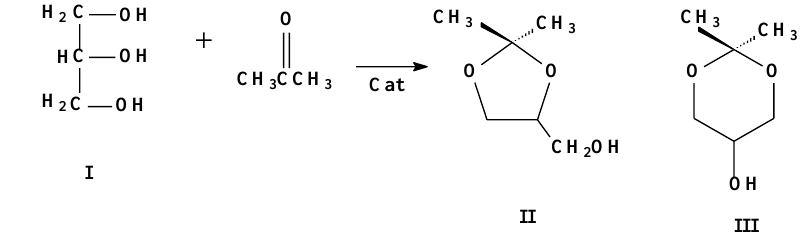
Figure 6. Glycerol acetalization over MIL-100(M) and MIL-53(M) catalysts.